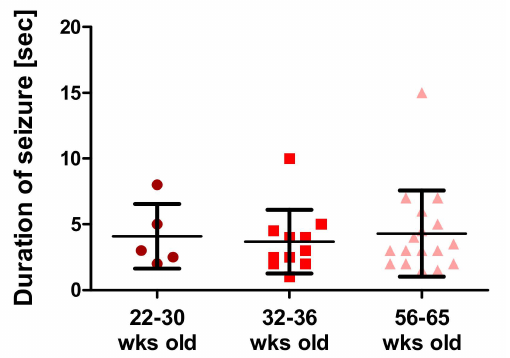
Figure 5. Duration of handling-induced seizures (seconds) in groups of 22–30 wks old (n = 5), 32–36 wks old (n = 11), and 56–65 wks old (n = 17) R1098Q mice. Error bars represent standard deviations (SD) with the mean seizure time for a given age group